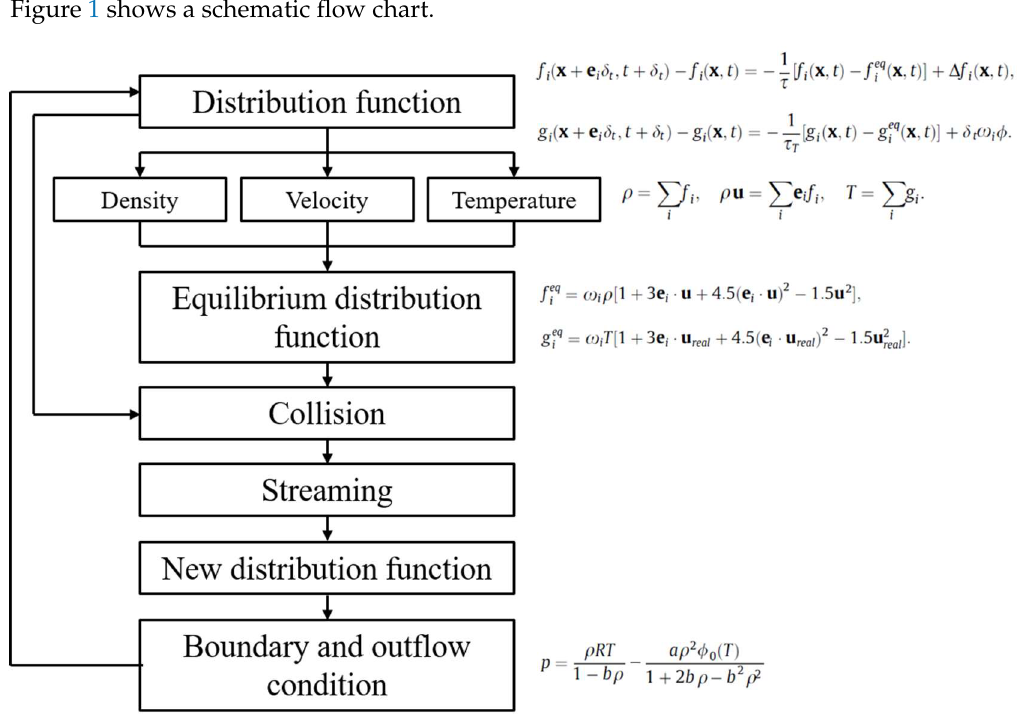
Figure 1. Lattice Boltzmann method flow chart.